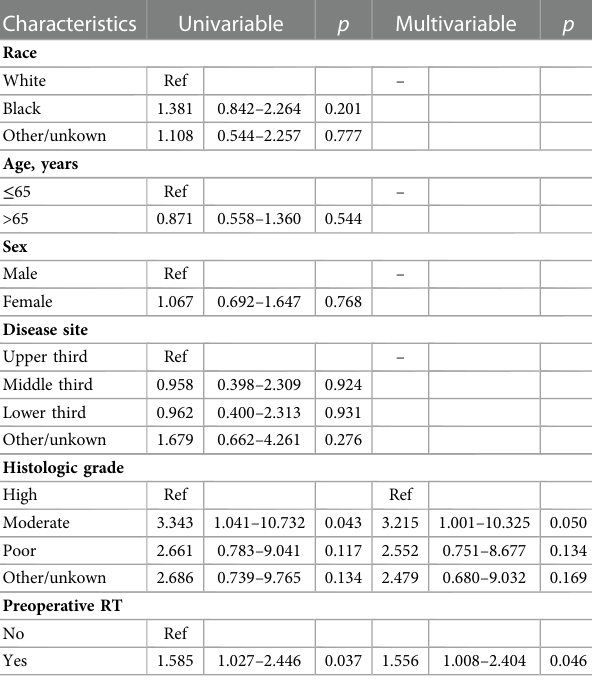
TABLE 3 Univariable cox analysis of the in fl uence of each characteristic on overall survival. Characteristics